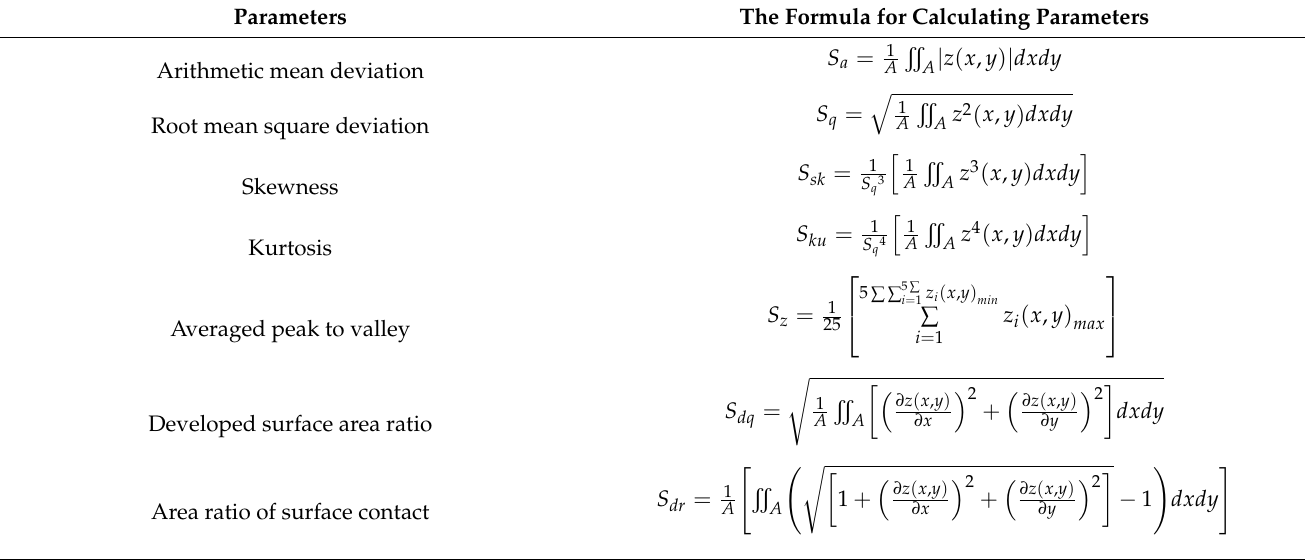
Table 4. Three-dimensional surface roughness